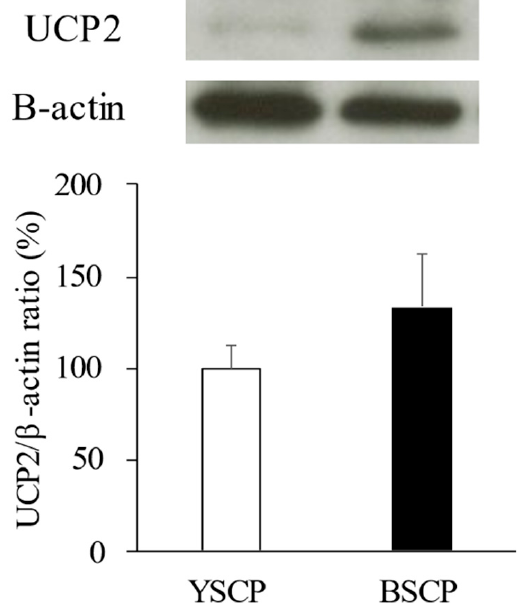
Figure 3. Effect of yellow soybean seed coat powder (YSCP) or black soybean seed coat powder (BSCP) on protein levels of UCP-2 in peritesticular fat of mice fed high-fat diets for 10 weeks. ■ , mice given BSCP; □ , mice given YSCP. Protein levels of UCP-2 are measured by western blot analysis. Values are presented as the mean ± standard error (SE, n = 10 or 11). Differences between groups were compared using Student’s t -test.